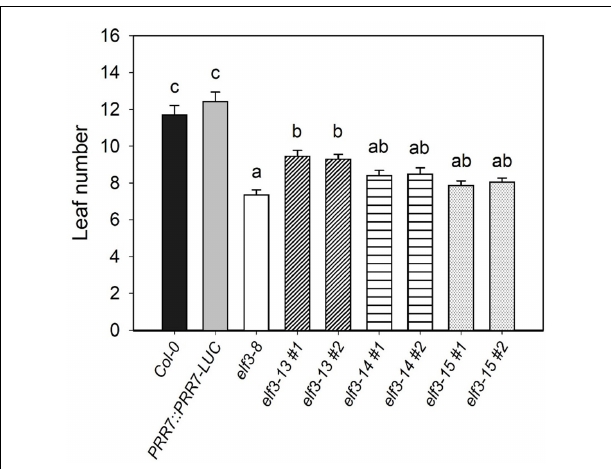
FIGURE 5 | Effect of elf3 mutations on flowering time. The Col-0 , elf3-8 , elf3-13 , elf3-14 , and elf3-15 were grown on soil under long days (16L:8D white-light cycles). Leaf count taken at time of 1 cm bolt. Two individual segregating lines from backcrossed progeny were selected for each elf3 mutant line. Error bars indicate ± SEM ( n = 3).